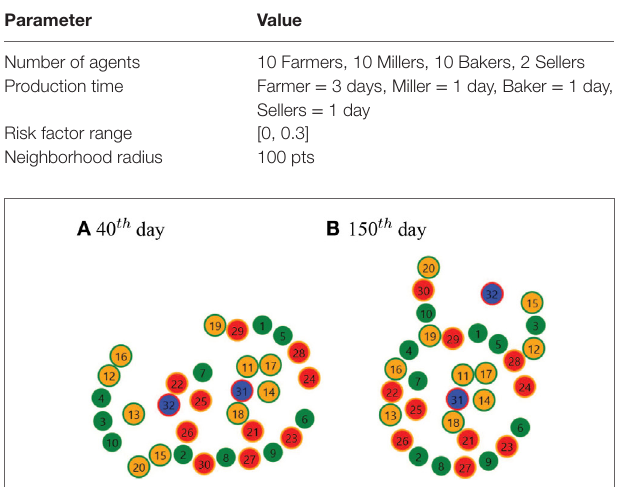
FigUre 16 | example of a change of agents arrangement in time: (a) On the 40th day, (B) on the 150th day